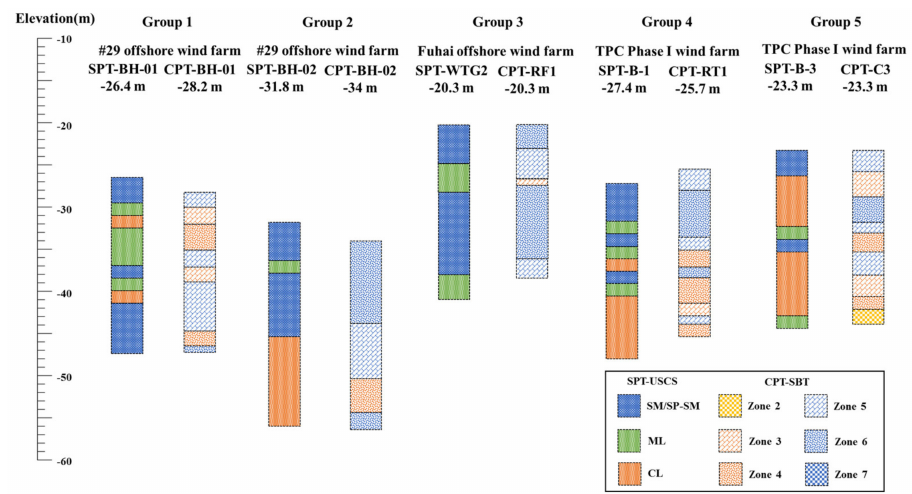
Figure 2. Comparison of SPT and CPT soil profiles at Taiwan offshore wind farm.